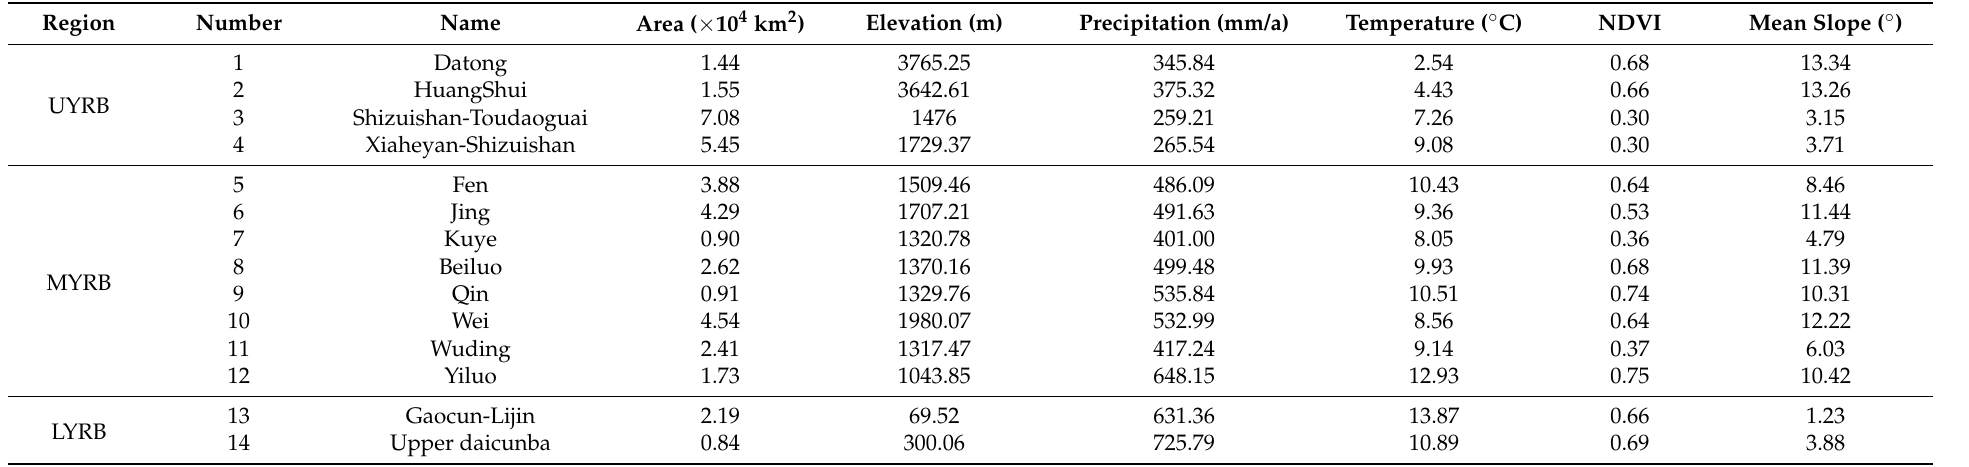
Table 1. Overview of 14 sub-basins in terms of climate, hydrology, and vegetation from